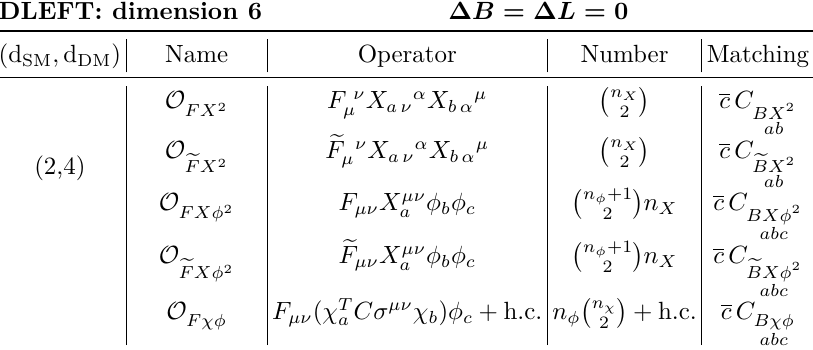
Table 20 . Dimension-six ∆ B = ∆ L = 0 operators in DLEFT, part 1. The first column gives the dimensions of the SM and DM part of the operator, the fourth column is the number of operators, and the fifth column is the additional matching contribution at the EW